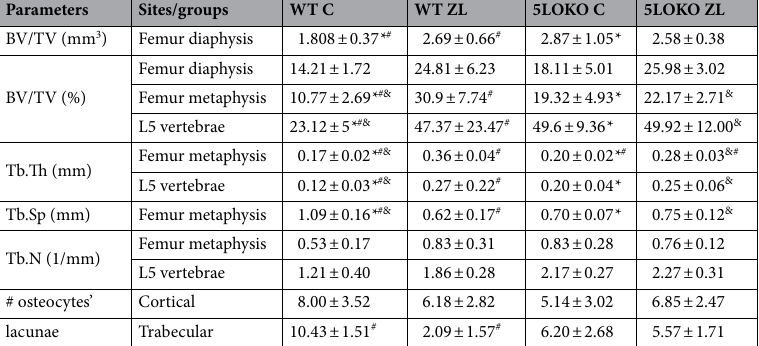
Table 1. Quantitative results of microCT and histological analysis for skeletal phenotyping in WT vs. 5LOKO mice treated or not with ZL. Results are presented as the means (± SD) for each parameter. In the comparison between columns, symbol* indicates comparison between the effect of 5LO knockout vs. WT; symbol # indicates the effect of ZL treatment in groups of same genotypes (WT vs. WT ZL); and symbol & indicates the effect of ZL treatment in different genotypes (WT vs. 5LOKO). Statistically significant differences are indicated between groups with equal symbols (p < 0.05).